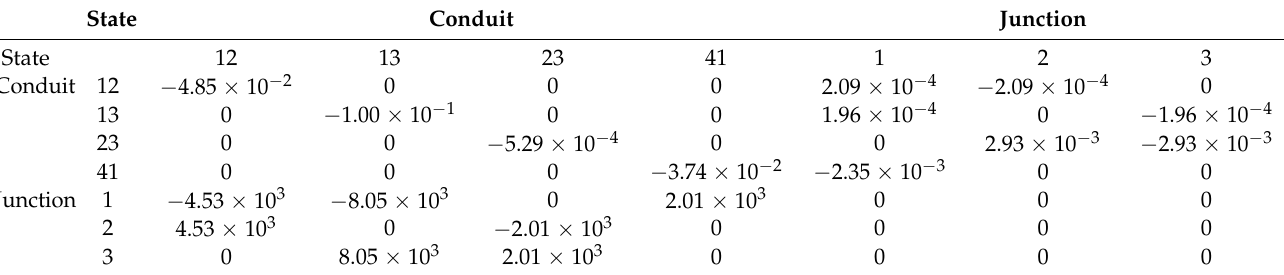
Table 2. State matrix A of the triangular network including network topology.